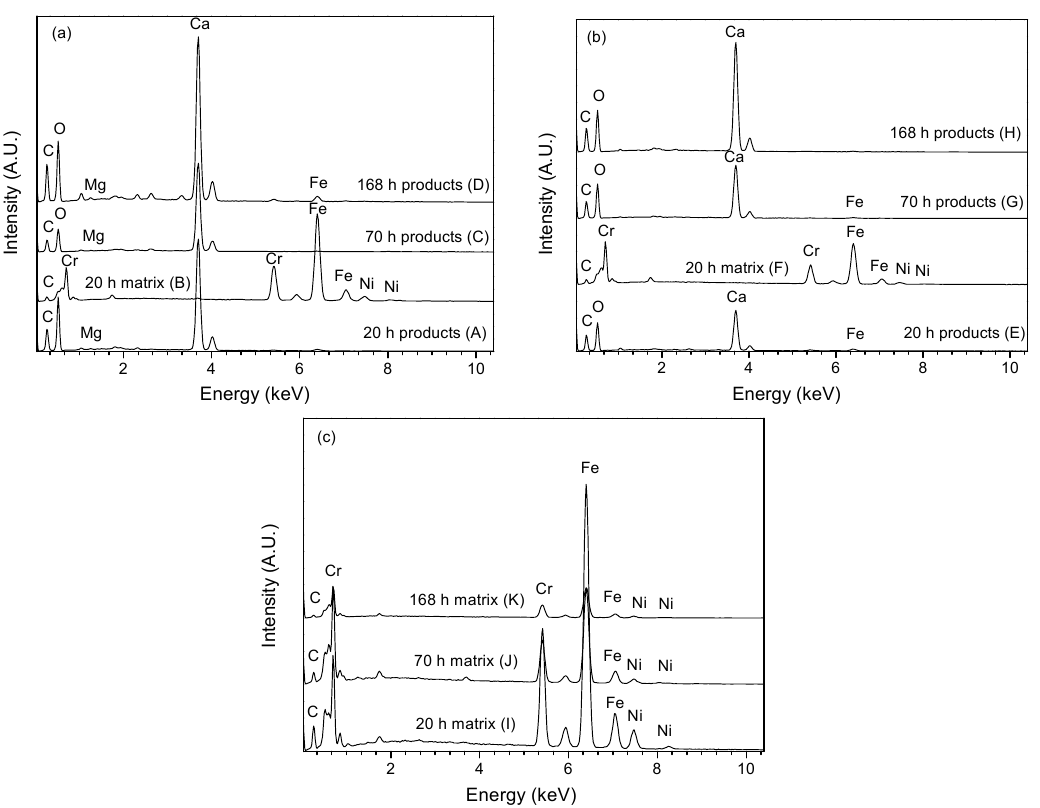
Figure 10. EDX spectra of 304 SS after cathodic polarization for different time in sea water at − 0.80 V ( a ), − 0.65 V ( b ), and − 0.50 V ( c ).